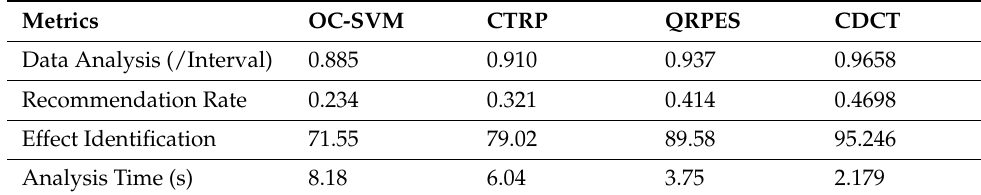
Table 4. Overall Comparative Summary